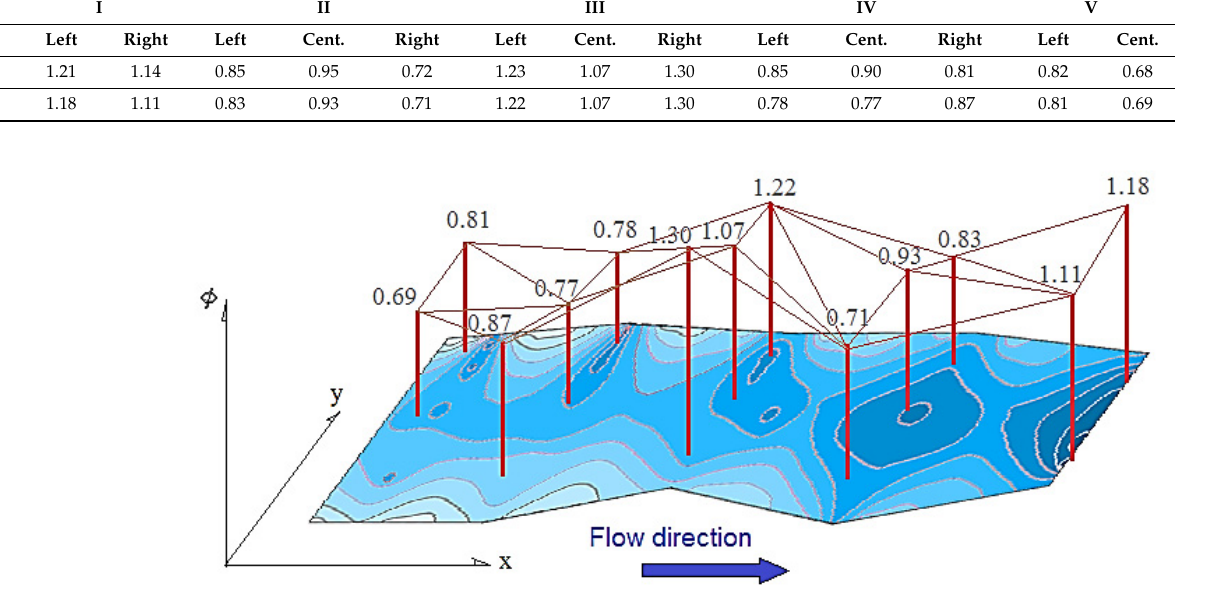
Table 4. Comparison between measured and calculated (cid:2030) .